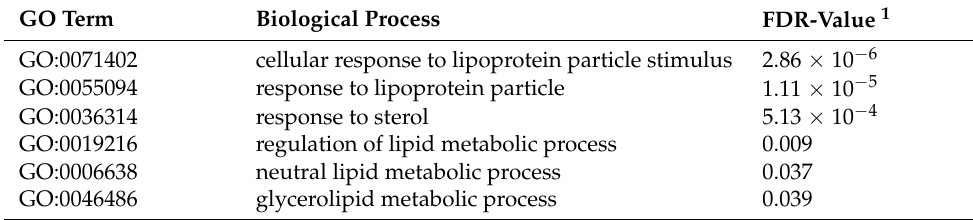
Table 2. Enriched biological processes related to lipid (Gene Ontology-GO) of DEGs